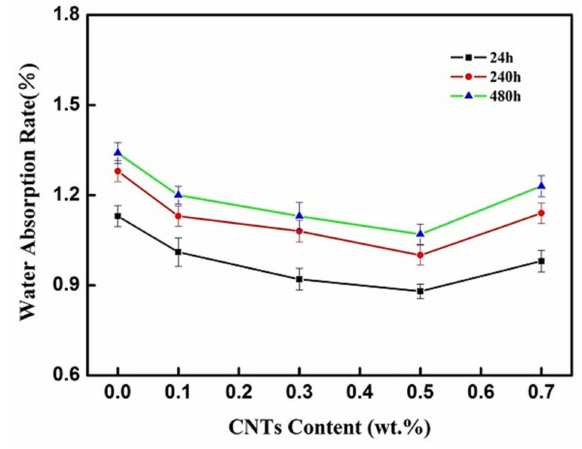
Figure 6. Water absorption of the CNT-BF / EP Coating by di ff erent additions of the